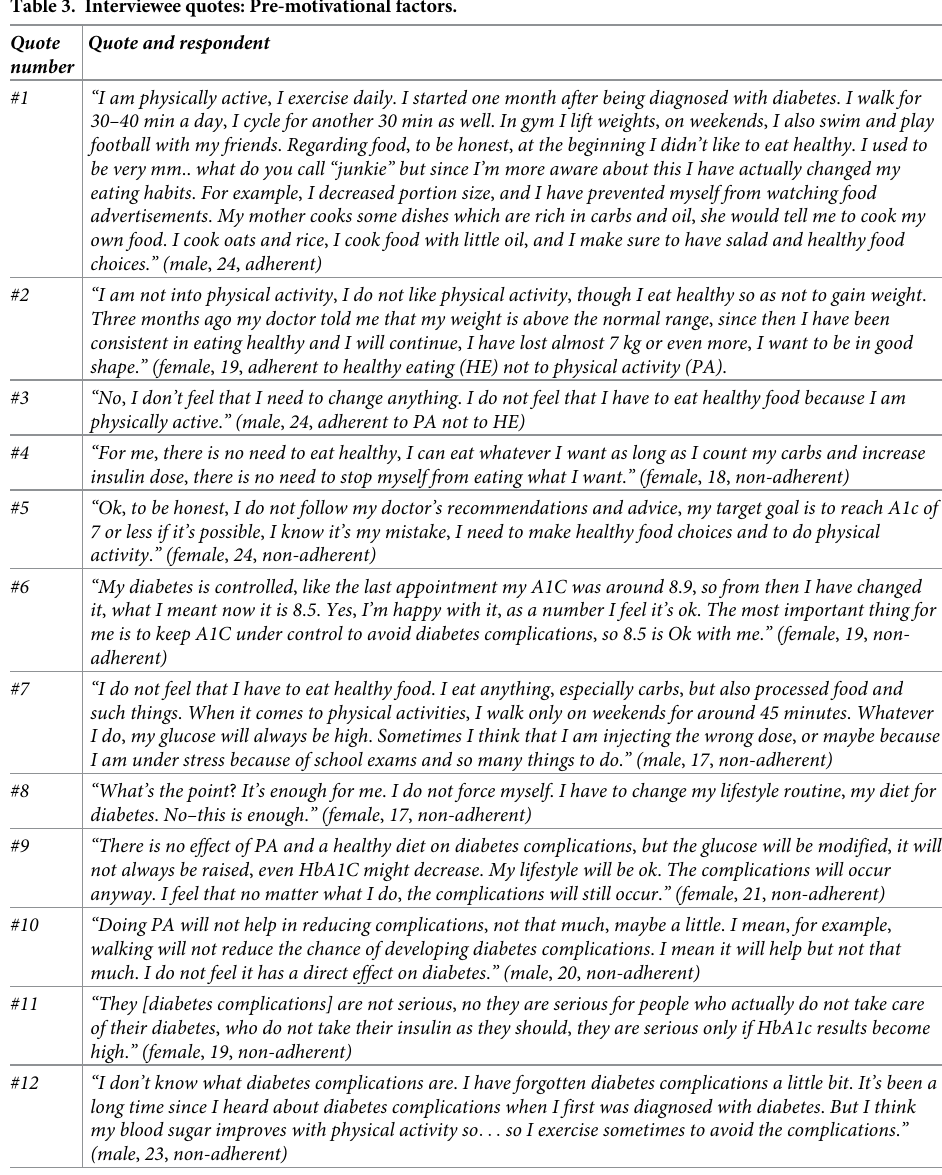
Table 3. Interviewee quotes: Pre-motivational